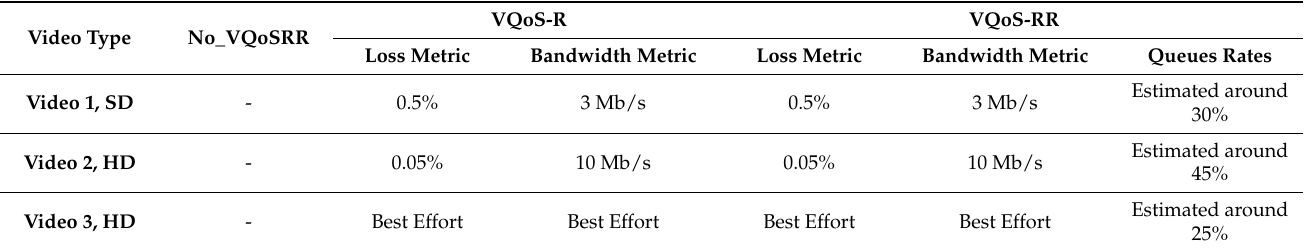
Table 4. Simulation parameters.